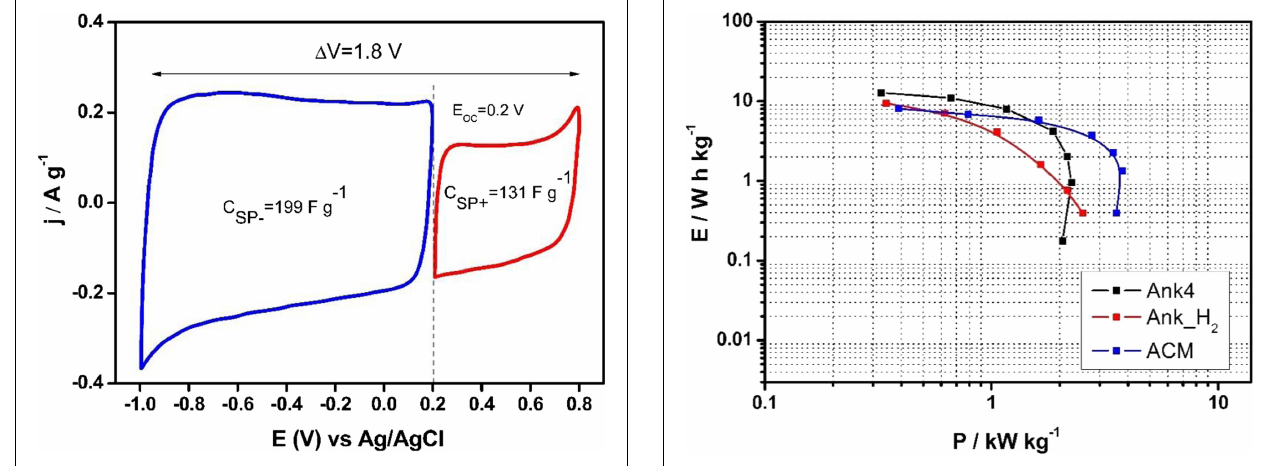
FIGURE 10 | Ragone plot for asymmetric supercapacitors of Ank4 ( ΔΔΔ U = 1.8V), Ank_H 2 ( ΔΔΔ U = 1.7V), ACM ( ΔΔΔ U = 2.0V) before performing charge–discharge test (0.5M Na 2 SO 4 )